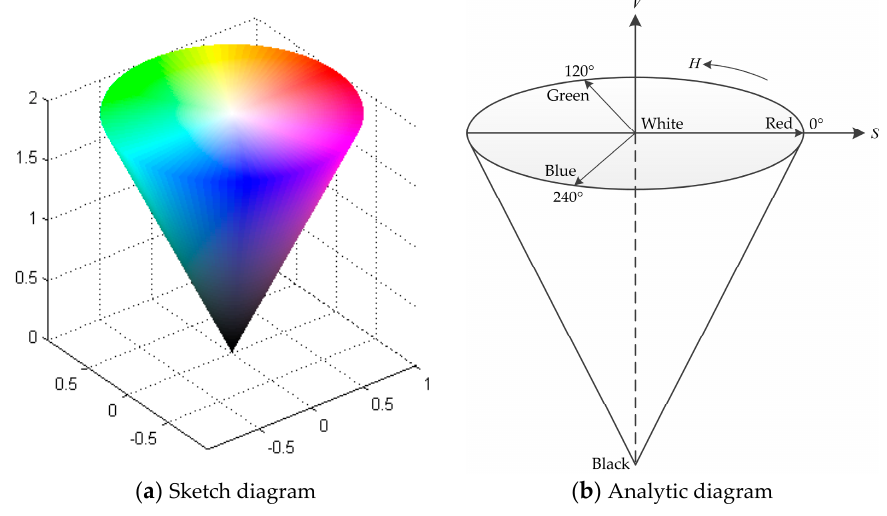
Figure 1. The HSV color space.